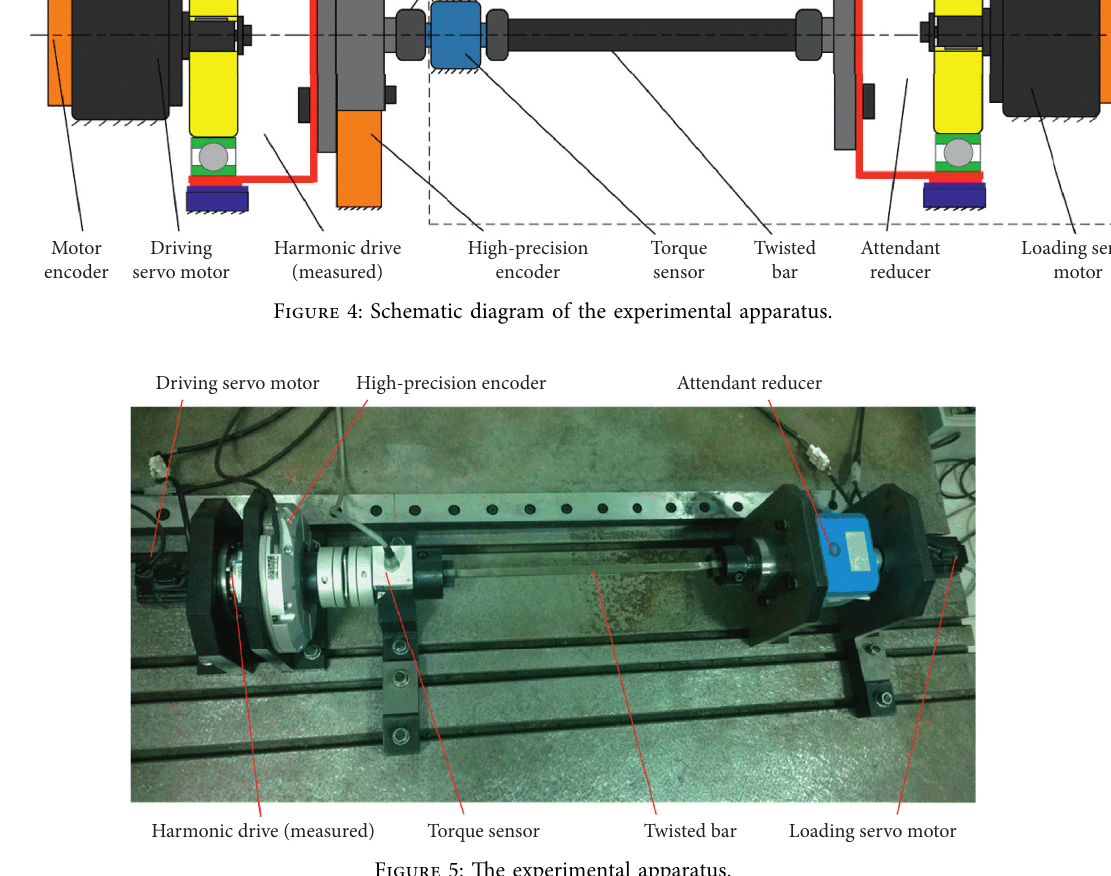
Figure 5: The experimental apparatus.